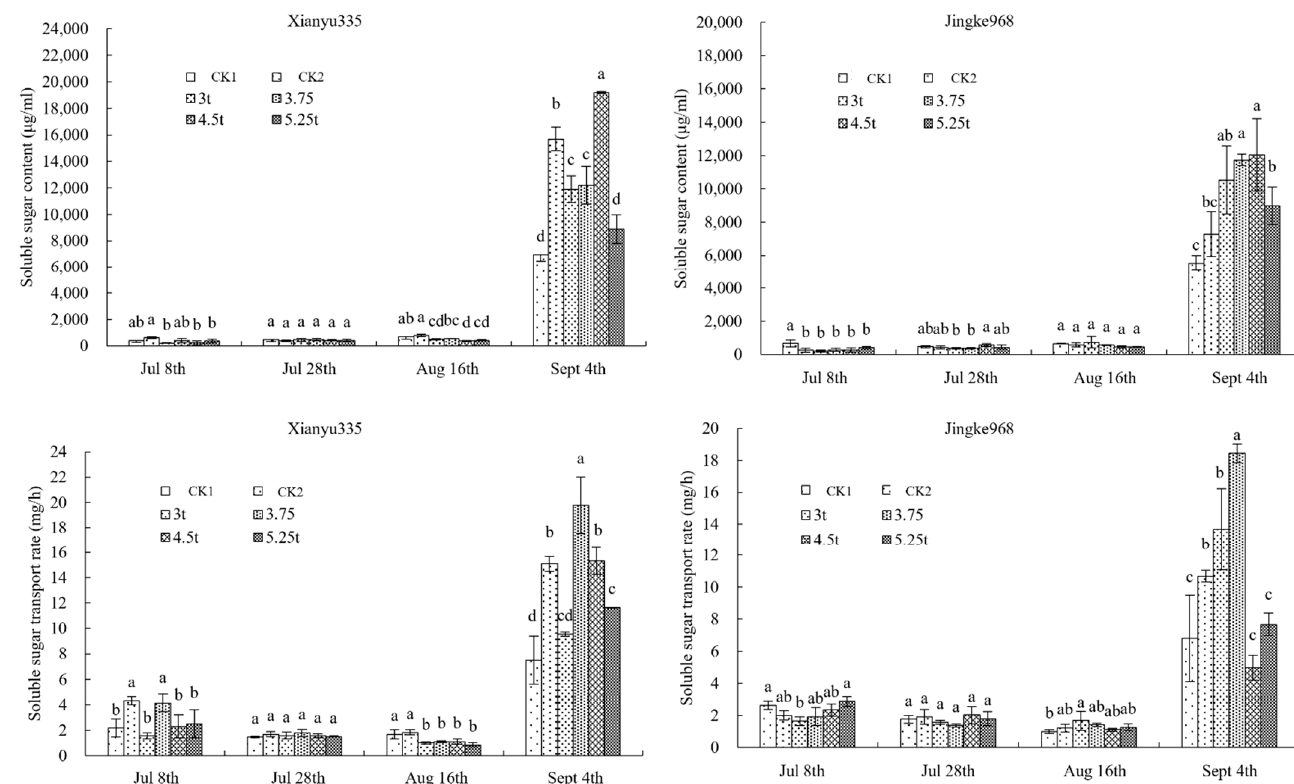
Figure 8. Effects of the carbon-based fertilizer on the soluble sugar content and the transport rate in the maize root bleeding. Notes: data are expressed as mean ± standard deviation. Different letters within the same column indicate a significant difference at the 5% level.